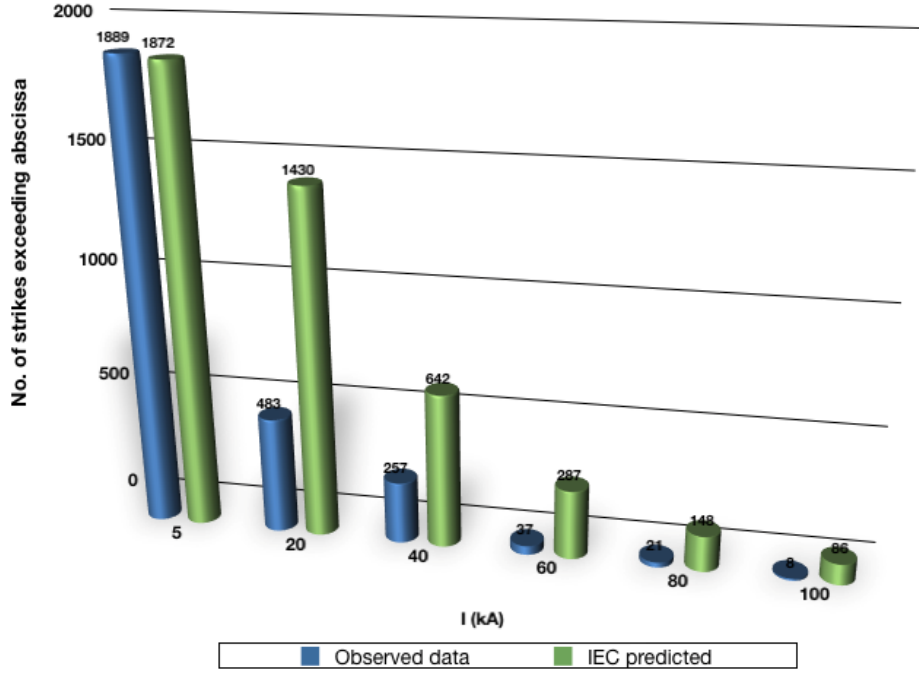
Figure 1. Comparison of lightning current amplitudes obtained from IEC prediction and those actually observed on the wind